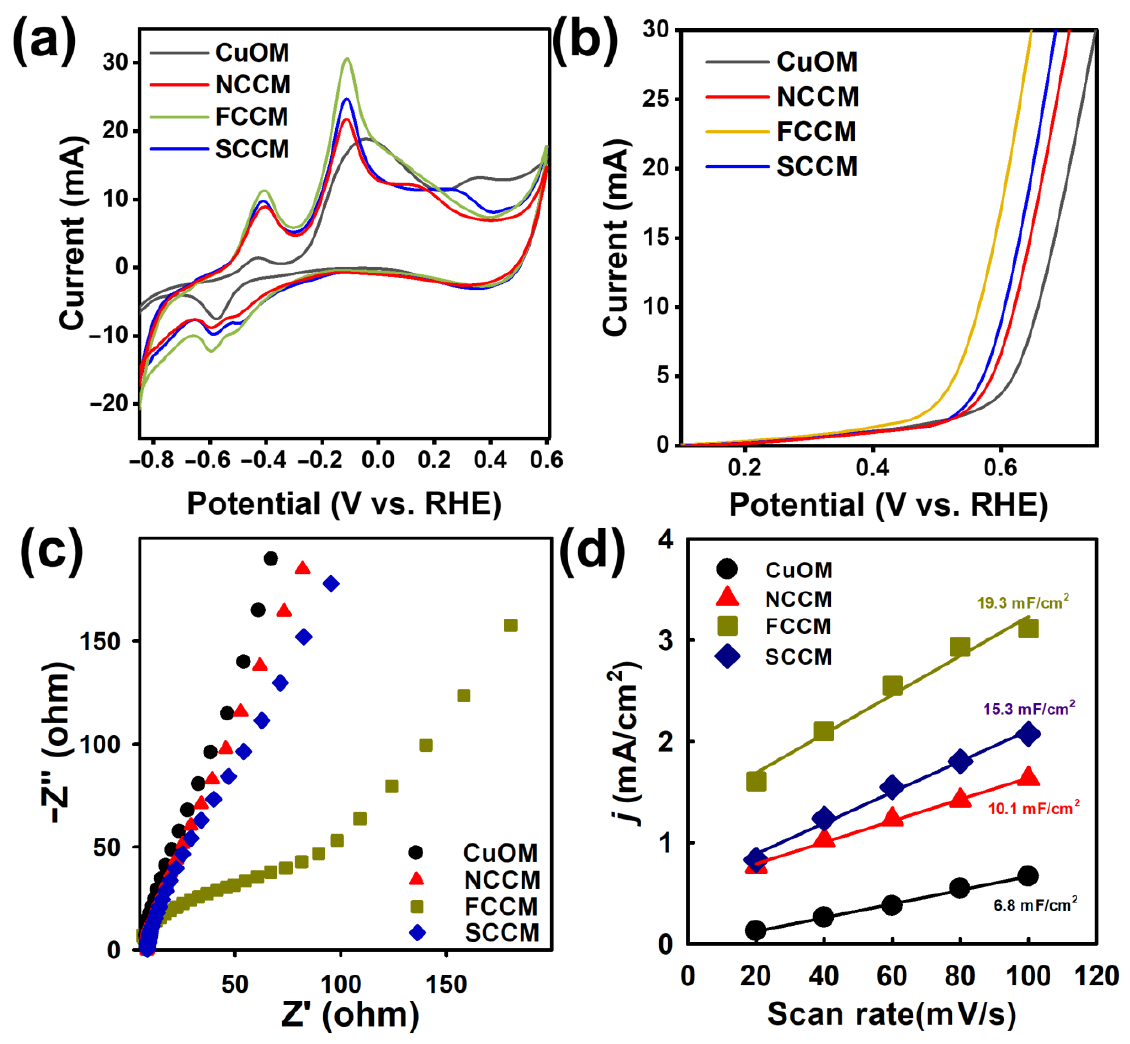
Figure 5. ( a ) CV curves at a scan rate of 60 mV/s, ( b ) LSV curves, ( c ) EIS Nyquist plots, and ( d ) C DL of different catalysts. of different